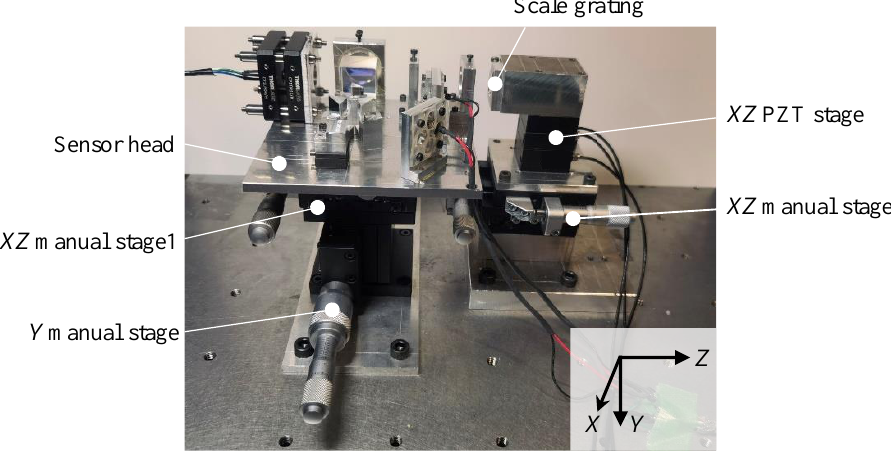
Figure 5. A photograph of the measurement setup.